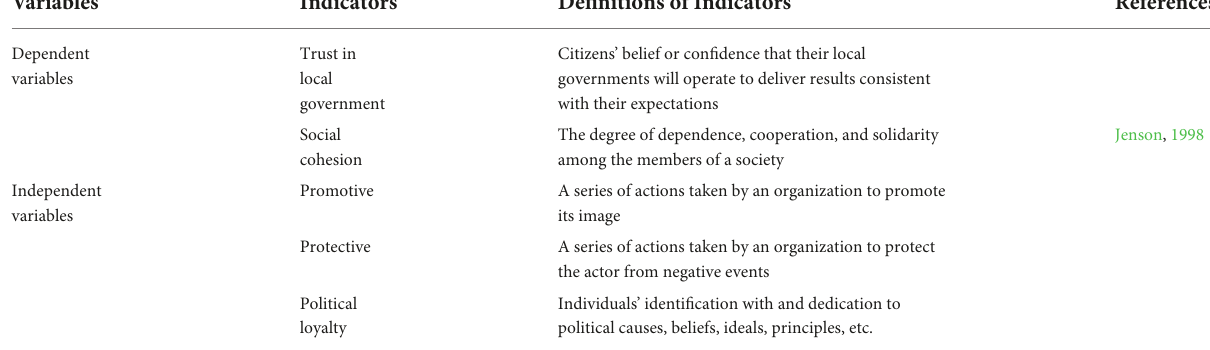
TABLE 1 Research variables and corresponding indicators.